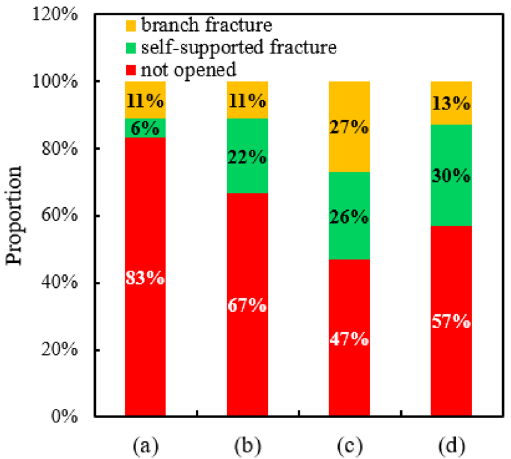
Fig. 10 The proportion of three kinds of natural fractures after hydraulic